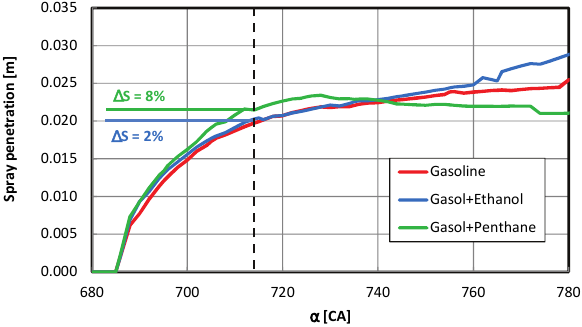
Fig. 13. The effect of the fuel stream range changes on the fuel type during injection and spray to the combustion chamber Obtained results of evaporated fuel mass allow to de- termine its total share in injected fuel dose. At 715 o CA the shares of evaporated mixtures are: